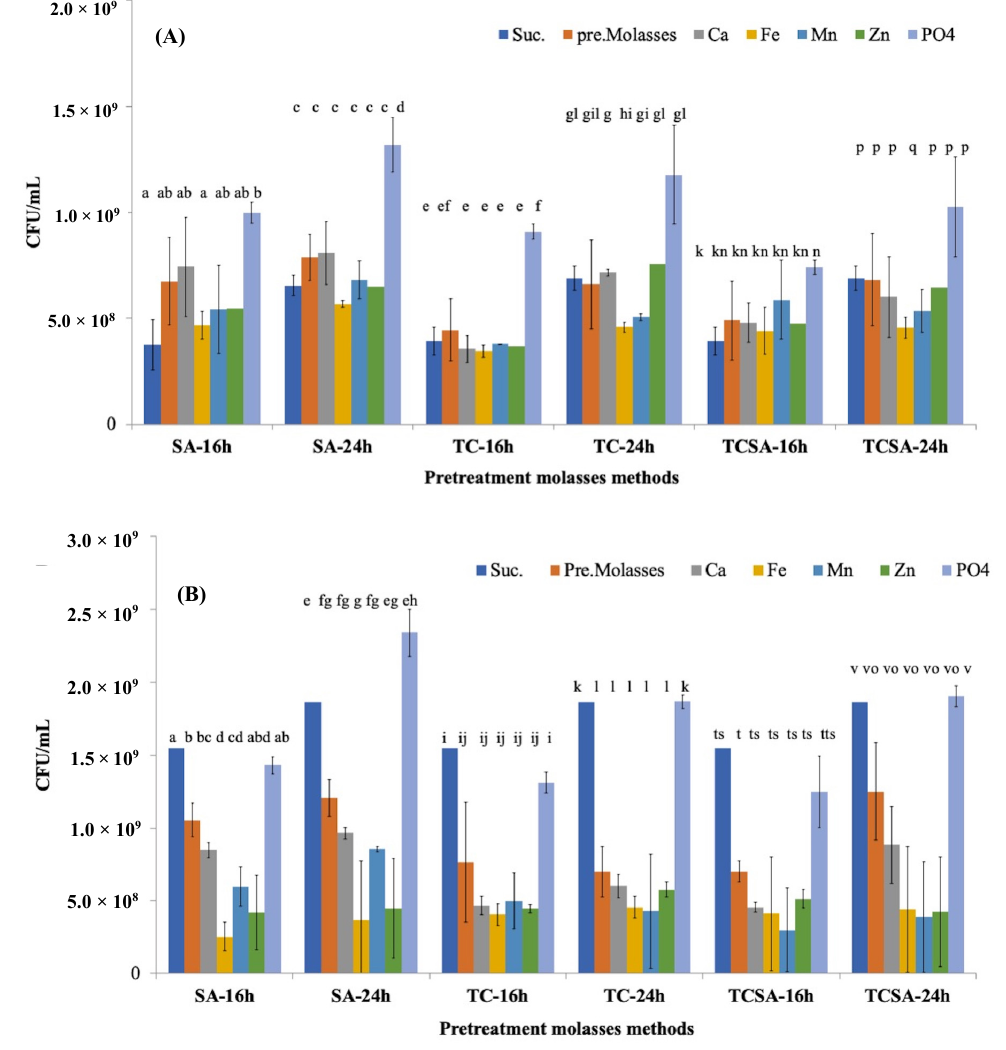
Figure 2. Effects of calcium (Ca), iron (Fe), manganese (Mn), zinc (Zn) and phosphate (PO 4 ) sup- plementation and pretreated molasses (pre.molasses) on growth of ( A ) EHA105-pEAQ strain and ( B ) GV3101-pEAQ strain compared to sucrose (Suc). Three molasses pretreatments (SA: sulfuric acid treatment; TC: tricalcium phosphate treatment; TCSA: tricalcium phosphate treatment) were used. Error bars represent one standard deviation of three replicates. Letters indicate mean separation results. Same letters: no significant difference ( p > 0.05).